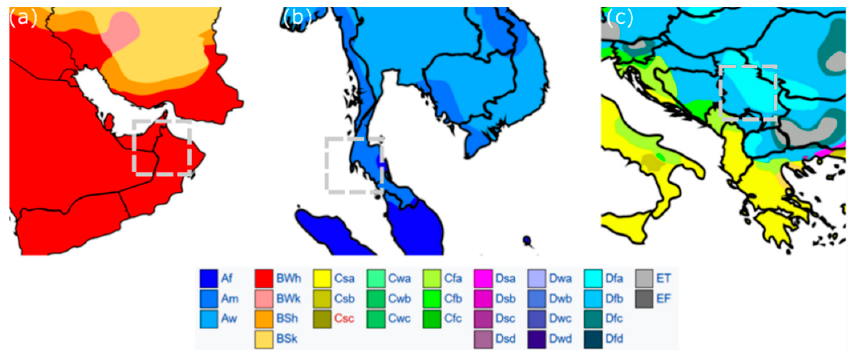
Figure 1. Three climate types considered for the cloud seeding experiments (grey rectangles): ( a ) Arid climate of UAE; ( b ) maritime climate of Thailand; and ( c ) temperate continental climate of Serbia. Modified after [33].